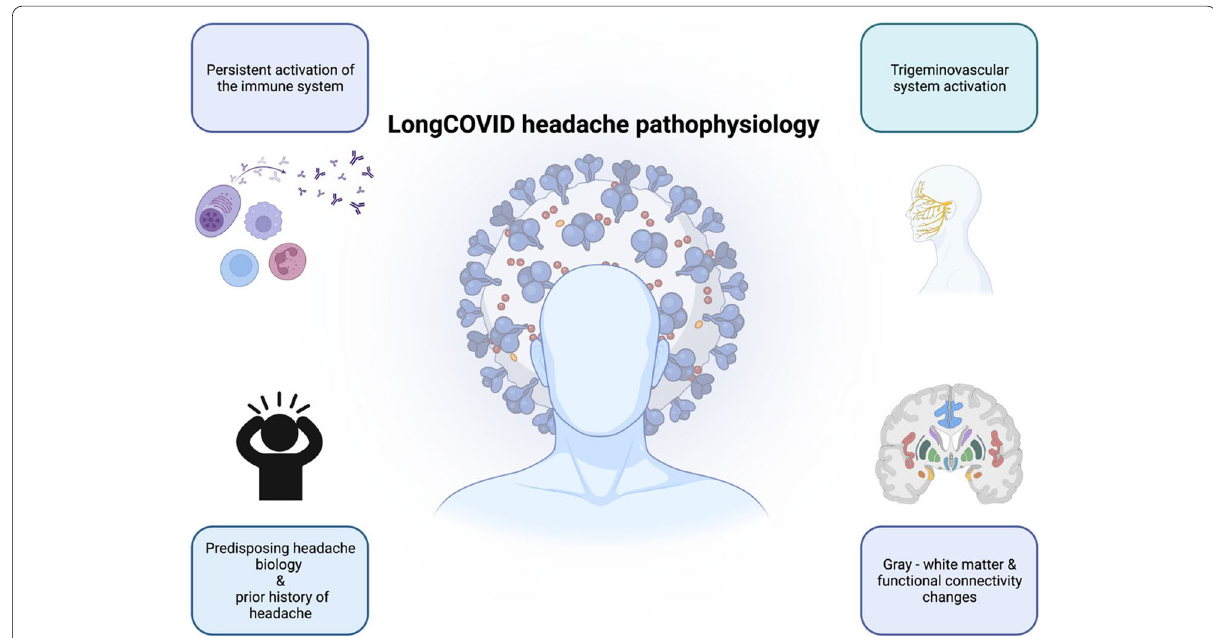
Fig. 1 Main pathophysiological mechanisms which have been hypothesized for long COVID